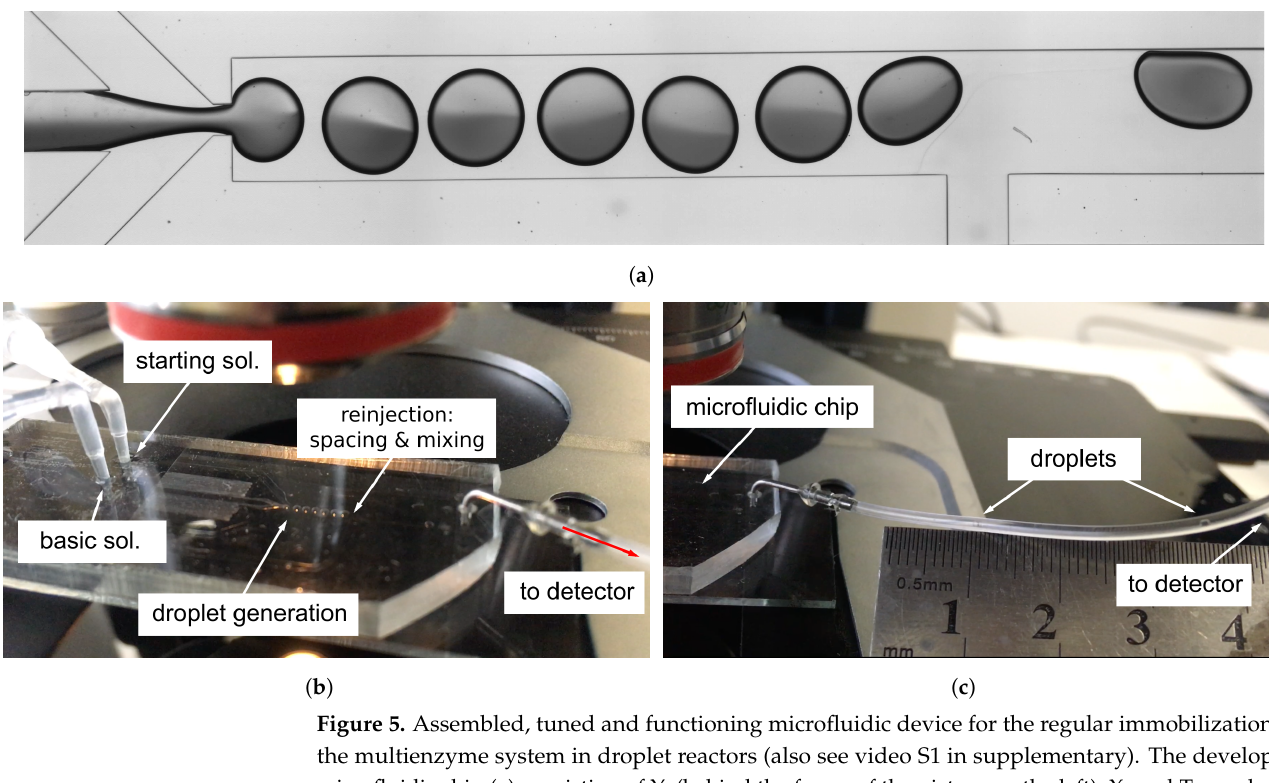
Figure 5. Assembled, tuned and functioning microfluidic device for the regular immobilization of the multienzyme system in droplet reactors (also see video S1 in supplementary). The developed microfluidic chip ( a ) consisting of Y- (behind the frame of the picture on the left), X- and T-crosshairs, in which the basic and starting solutions are coupled, droplets are formed, mixed and distanced. One of the components of the dispersed phase was colored with Coomassie Brilliant Blue G-250 for better visualization. The fluid supply pressures were selected to ensure the generation of droplets in a volume of 0.13 µ L with a frequency of 12 drops per minute ( b ), and allowing the droplets to move away from each other at a distance of 2–2.5cm ( c